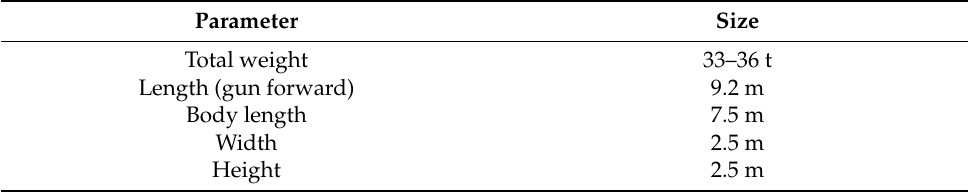
Table 1. Parameters of Type 15 Light